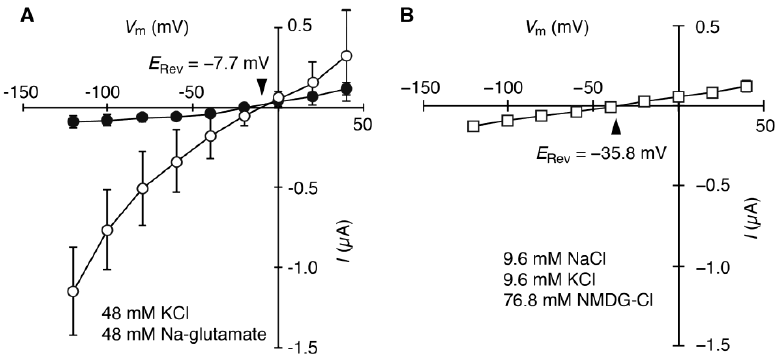
Figure 6. Current/voltage relationship of HvCNGC2-3 -expressing oocytes in a gluconate-containing medium and N -methyl- D -glucamine-containing medium. Currents were analyzed with the two-electrode voltage-clamp technique. Oocytes were treated with 8Br-cAMP (10 µM) for 30 min before measurement. Oocytes expressing HvCNGC2-3 (open symbols) or water-injected controls (closed symbols) were bathed in a solution containing 48 mM KCl and 48 mM Na-gluconate ( A ) and 9.6 mM KCl, 9.6 mM NaCl and 76.8 mM N -methyl- D -glucamine-Cl [NMCG-Cl] ( B ). Current values are means ( n = 9 for water-injected control, n = 19 for HvCNGC2-3 of gluconate-containing medium and n = 4 for HvCNGC2-3 of N -methyl- D -glucamine-containing medium) ± SD. E rev , reversal potential. The permeability ratio of K + , Na + , and Cl − (P K , P Na and P Cl , respectively) was calculated as P K :P Na :P Cl = 1:0.63:0.03, based on the Goldman–Hodgkin–Katz equation. This indicates that HvCNGC2-3 allows permeation of Na + and K + to a similar extent, but Cl − permeation is virtually excluded. cNMP-activated currents associated with HvCNGC2-3-injected oocyte was not observed in the bathing solution in which NaCl and KCl were replaced with CaCl 2 (Y. Nobukiyo, unpublished data,